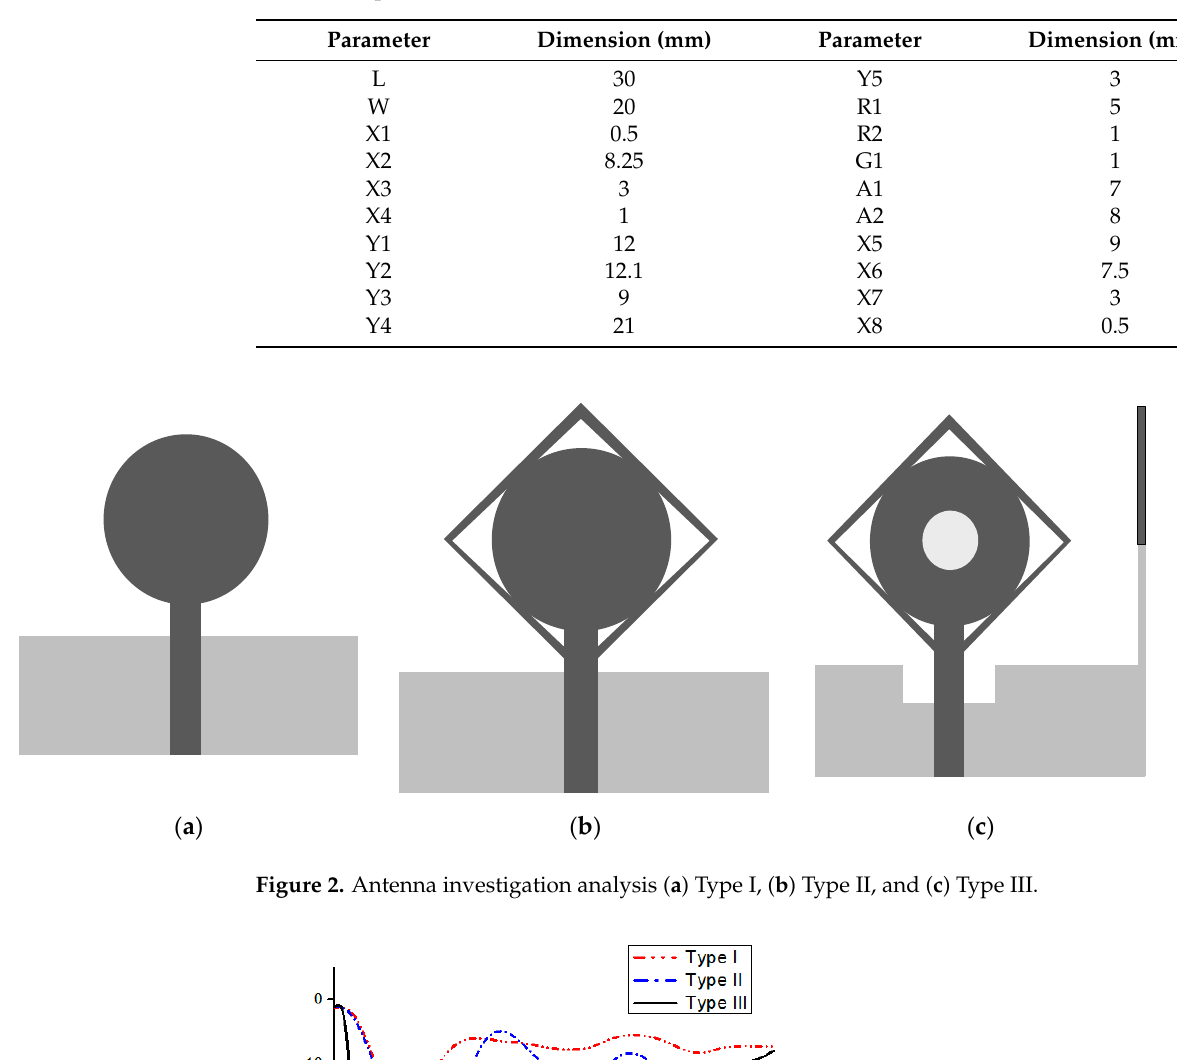
Figure 1. Geometry of the proposed single-element antenna. ( a ) Front view, ( b ) radiation patch elements, and ( c ) back view. Table 1. Proposed antenna dimension.